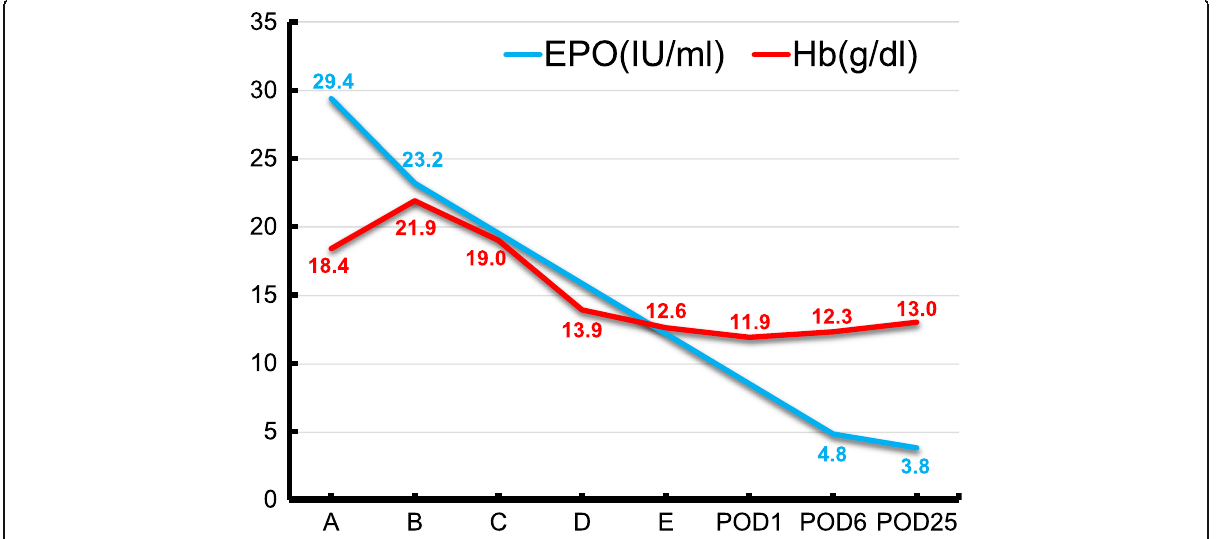
Fig. 1 Changes in hemoglobin and erythropoietin levels. A, 9 years prior to reference to our hospital; B, at the time of the reference to our hospital; C, after phlebotomy; D, shortly before the operation; E, shortly after the operation, EPO, erythropoietin; POD, postoperative